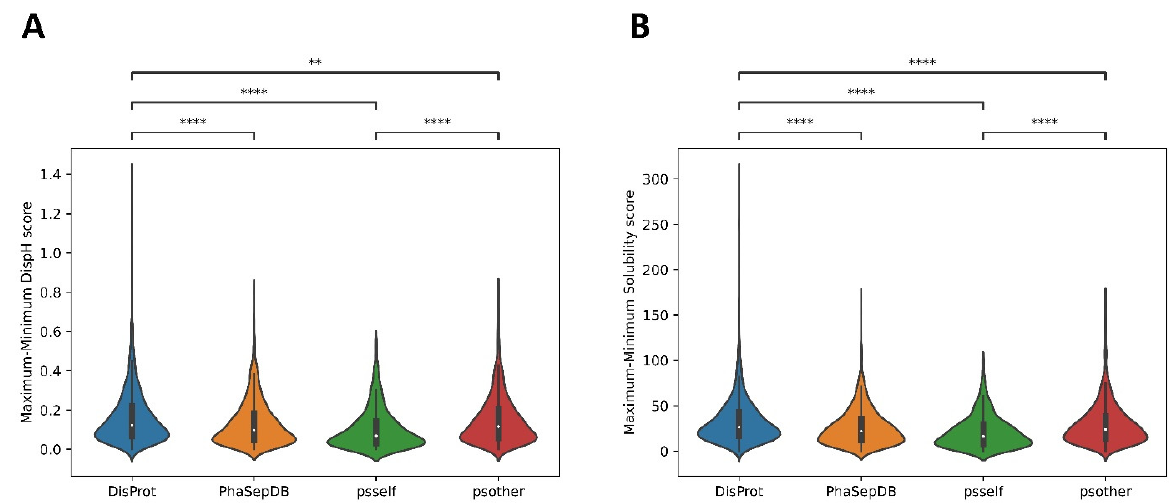
Figure 5. Difference between maximum and minimum solubility ( A ) and disorder ( B ) scores for DisProt, PhaSepDB, psself, and psother datasets. The DisProt dataset exhibits a wider dispersion, understood as the difference between the maximum and minimum values, in comparison with the PhaSepDB, psself, and psother datasets. In consonance with previous results, psother and psself datasets are significantly different *. * ( A ) Solubility: DisProt-PhaSepDB (1.526 × 10 − 19 ); DisProt– psself (2.064 × 10 − 31 ); DisProt–psother (5.508 × 10 − 06 ); psself-psother (2.009 × 10 − 14 ). * ( B ) Disorder: DisProt-PhaSepDB (4.496 × 10 − 14 ); DisProt–psself (3.325 × 10 − 29 ); DisProt–psother (5.526 × 10 − 03 ); psself-psother (8.586 × 10 − 17 ). Two asterisks (**) indicate p ≤ 0.01. Four asterisks (****) indicate p ≤ 0.0001.